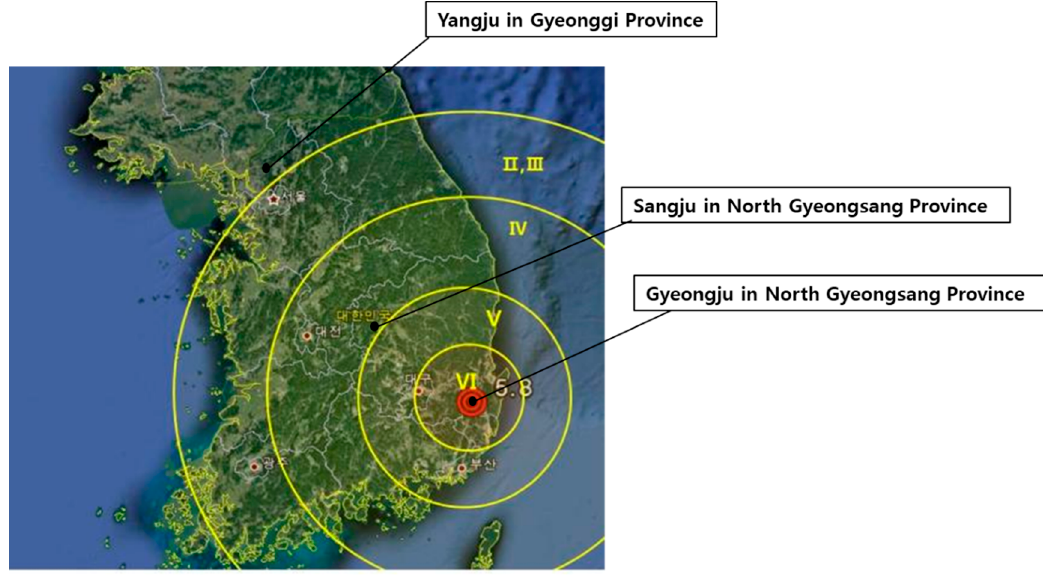
Figure 1. Distribution of seismic intensity.